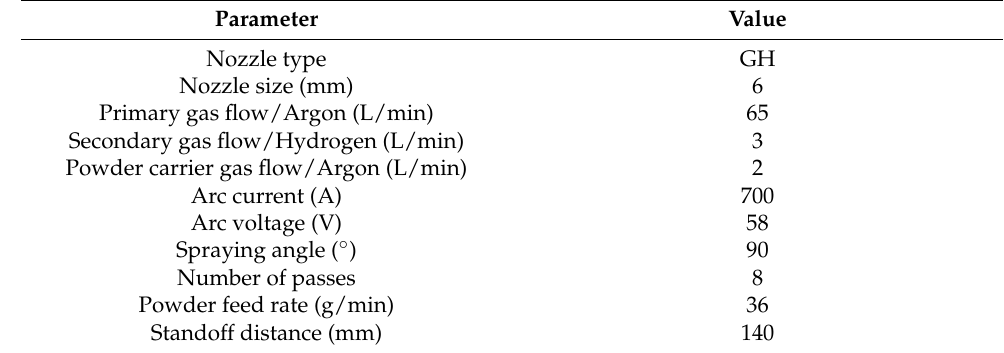
Table 2. APS process operating parameters for the deposition of the micro- and nanocrystalline HEA AlCrFeCoNi